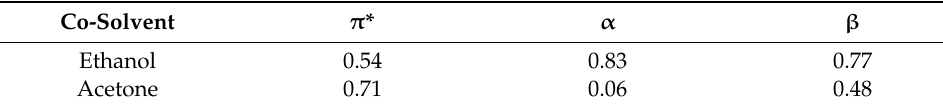
Table 4. Co-solvent solvatochromic parameters